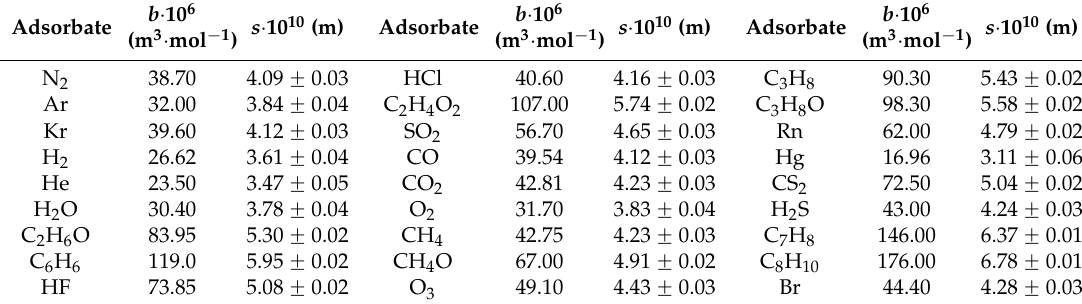
Table 3. Estimations of the effective cross-sectional diameters s = ( b / N A ) 1/3 of selected adsorbate molecules according to the tabulated b values [28] contained in van der Waals’s equation. The standard uncertainty of s is estimated from u b = 10 ´ 8 m 3 ¨ mol ´ 1